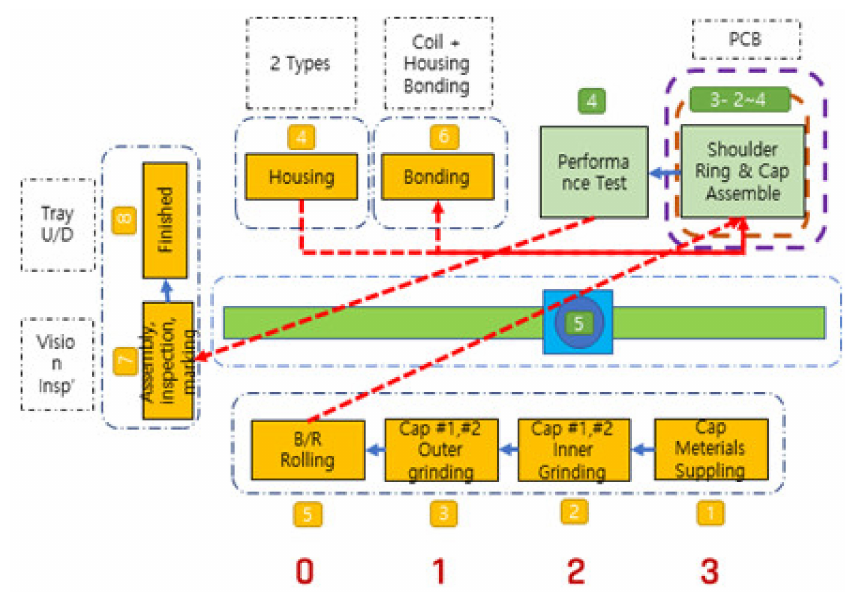
Figure 11. Motor factory modeling.